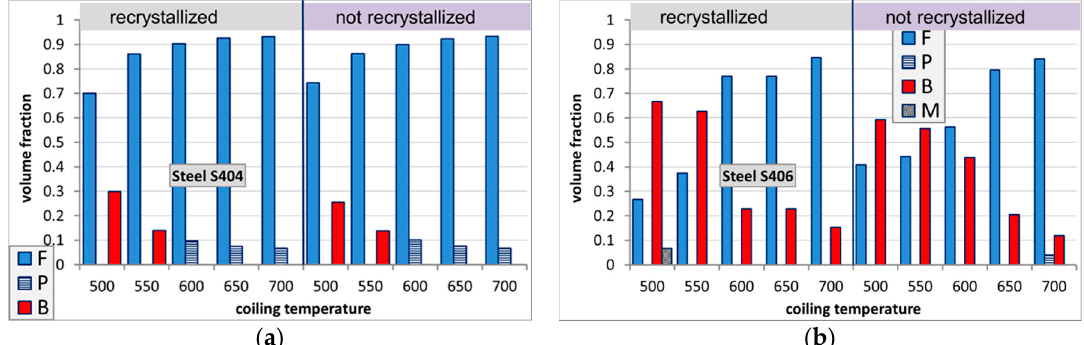
Figure 16. Effect of the coiling temperature on the volume fractions of phases for the HSLA NbTiMo steel S404 ( a ) and bainitic TiMo steel S406 ( b ).